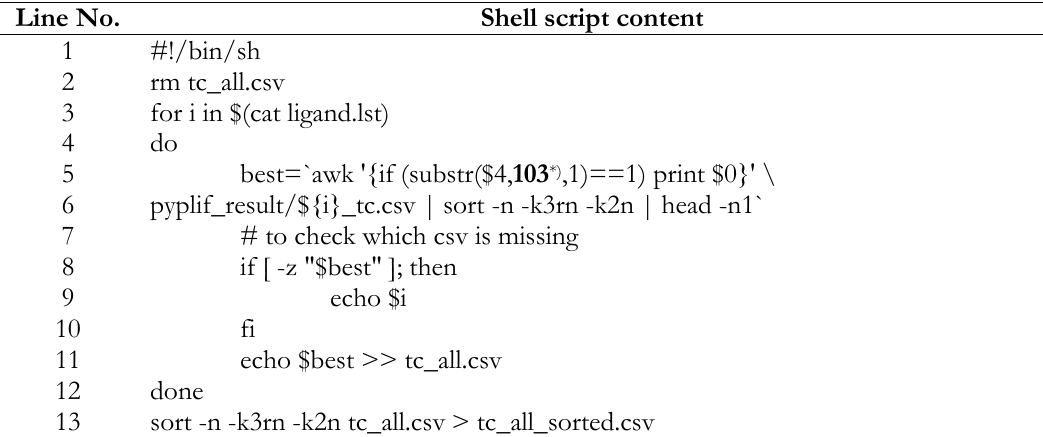
Table I. Shell script to filter based on the predefined interaction bitstring (Radifar, 2013 a ). Line